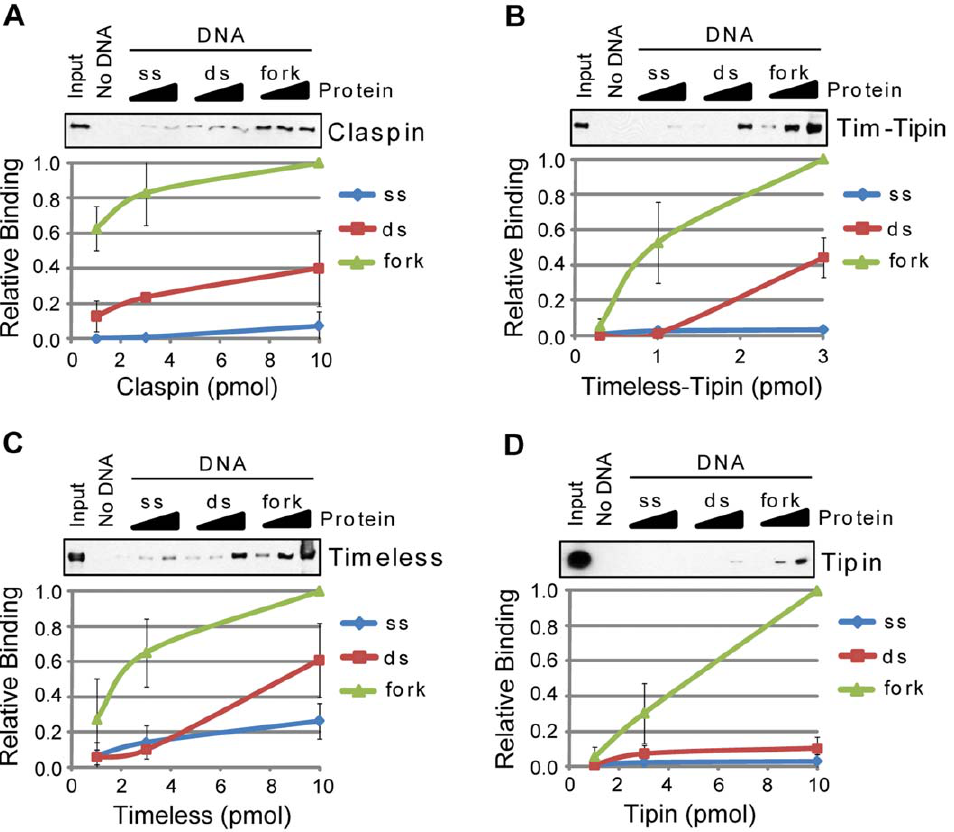
Figure 4. The DNA damage checkpoint mediators Claspin, Timeless, and Tipin preferentially bind branched DNA. The association of each of the indicated purified proteins with no DNA (beads alone), single-stranded (ss), double-stranded (ds), and branched, replication fork-like (fork) DNA was analyzed by SDS-PAGE and immunoblotting. Each of the following proteins was analyzed for binding to each DNA structure: (A) Claspin, (B) Timeless-Tipin (Tim-Tipin) complex, (C) Timeless, and (D) Tipin. Reactions were carried out as described in the Methods section.